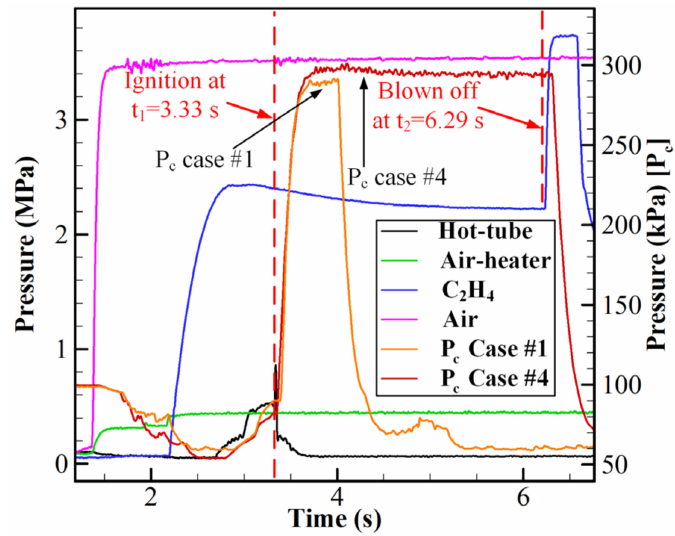
Figure 9. Air-heater and combustor pressure with time (Case